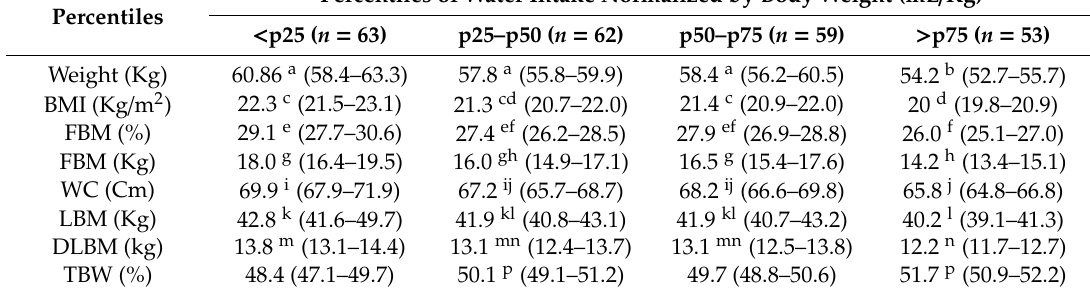
Table 6. Di ff erences in anthropometric and body composition variables according to water intake per body weight percentiles in